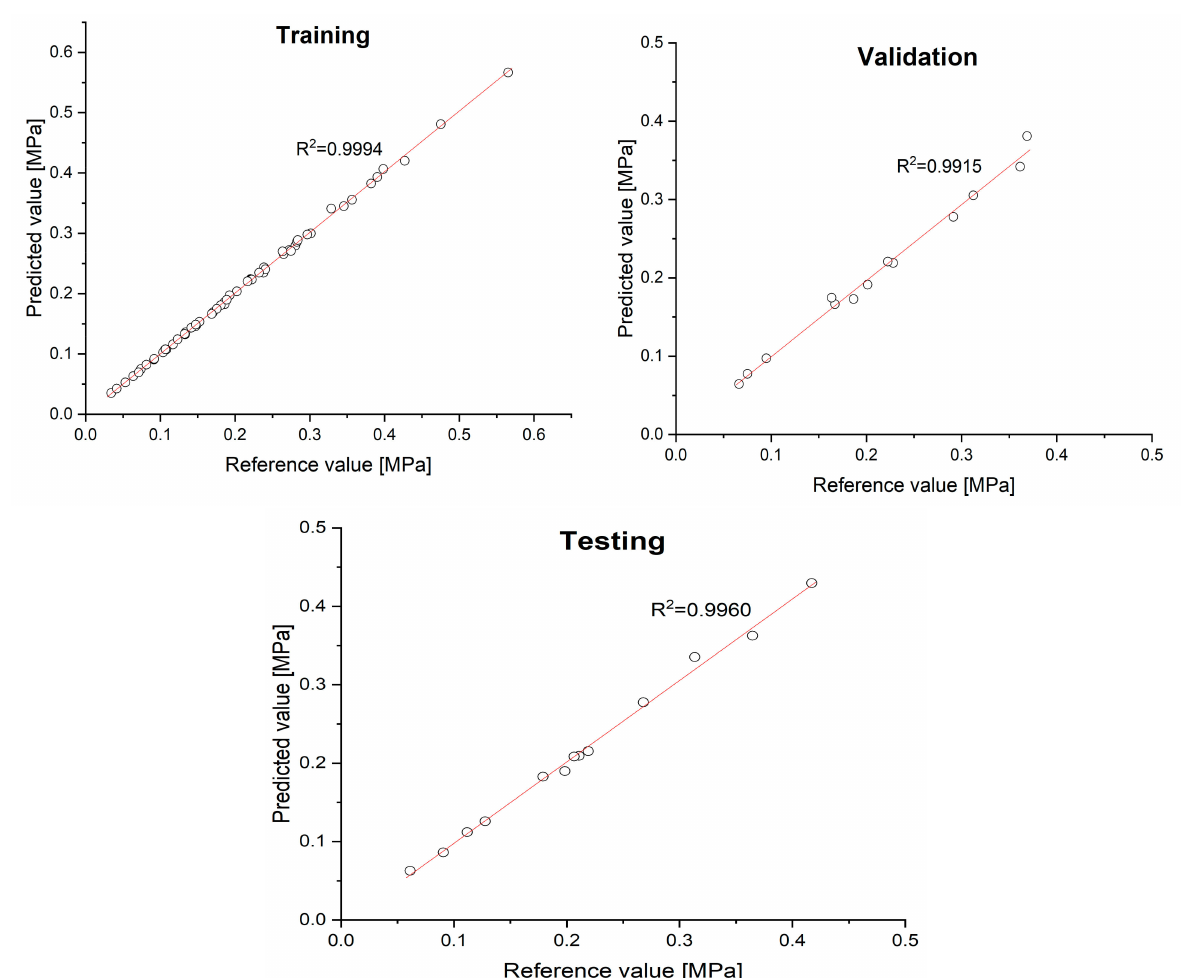
Figure 4. Dependencies between the values of the average methane seam pressure predicted by the neural network and the reference values determined for the training, validation and test